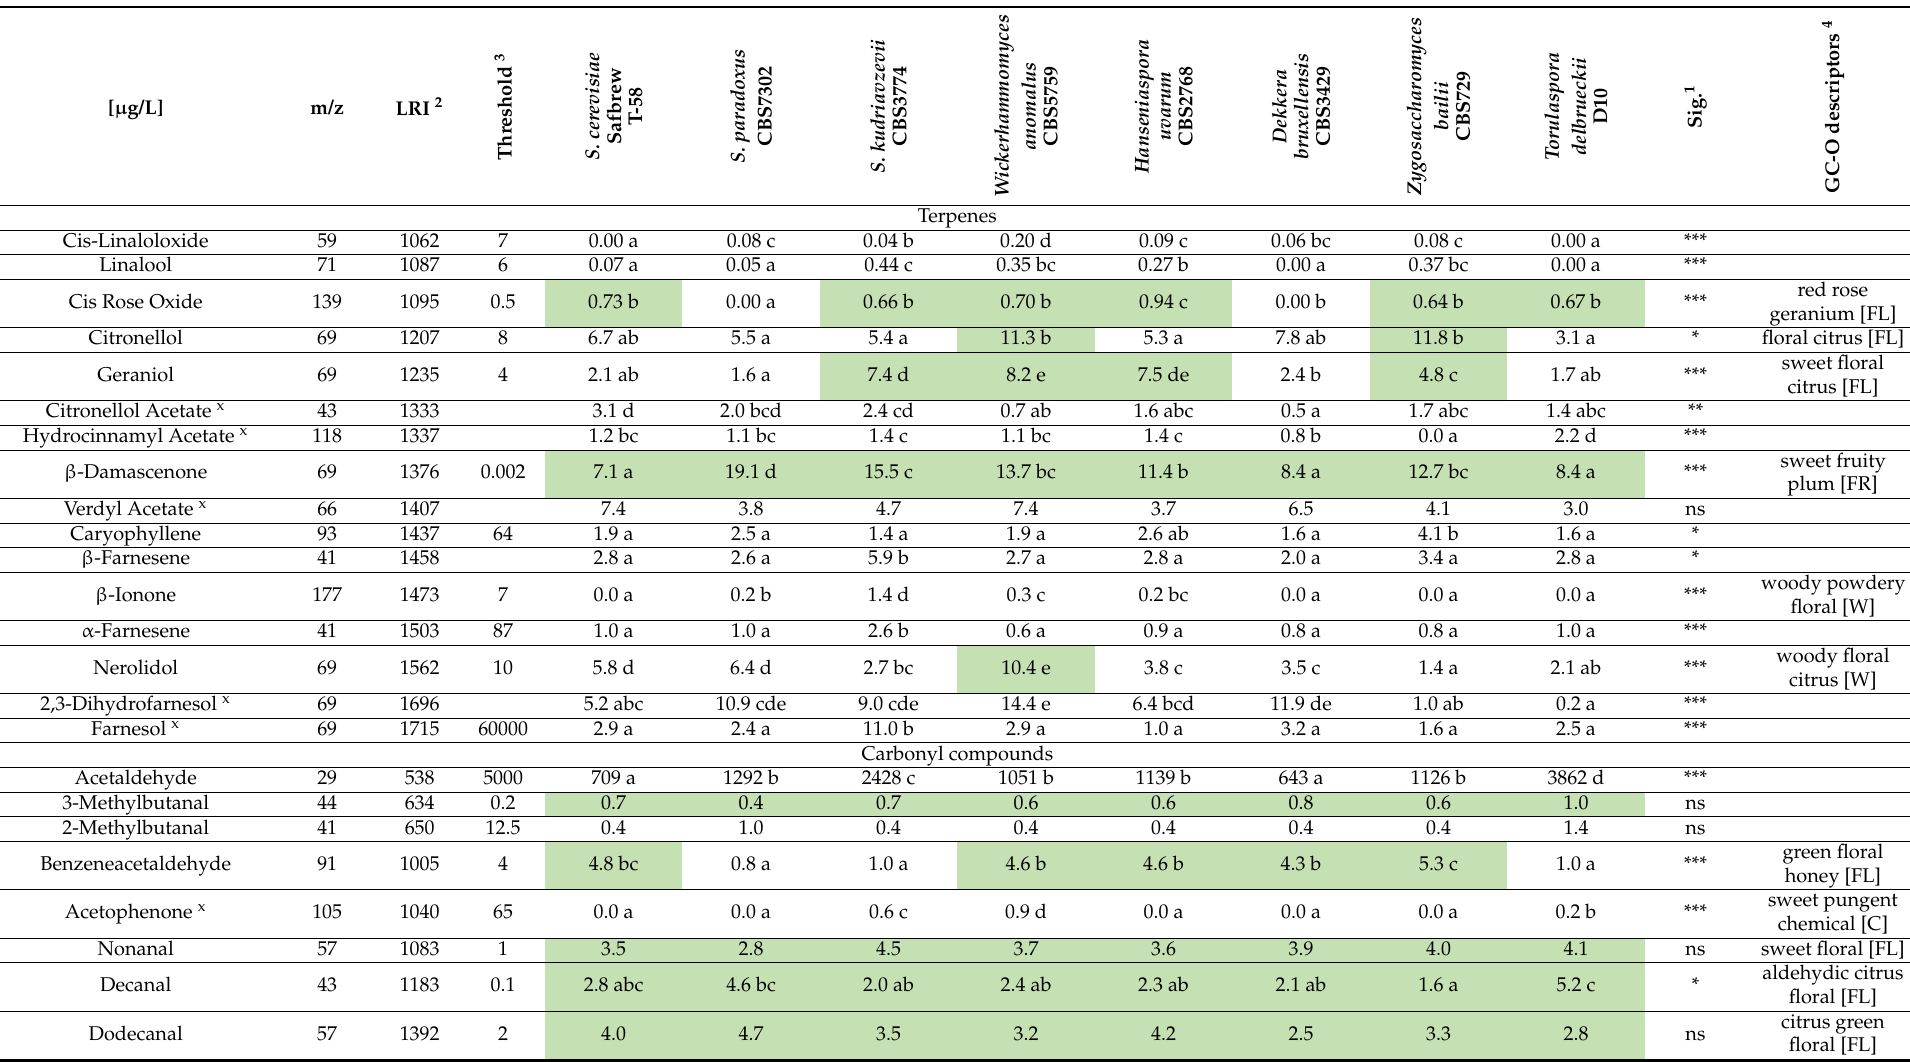
Table 5. Terpenes and other volatiles in beers produced with different non-conventional